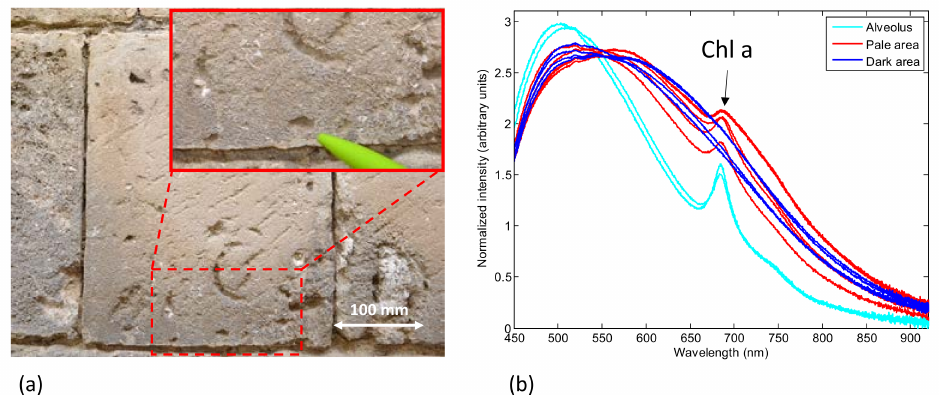
Figure 7. On-site LIF analysis of the biological growth on a stone cultural heritage. ( a ) Ashlar of the external walls with a dark alteration; ( b ) LIF spectra in different spots of the same ashlar. The spectra are normalized to their standard